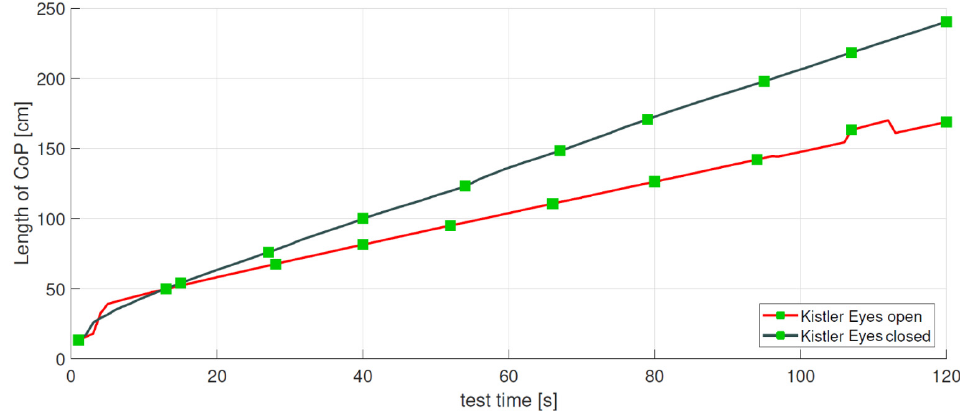
Figure 4. Absolute CoP length curve for bipedal stand over the measurement time, with open eyes (red) and closed eyes (black).